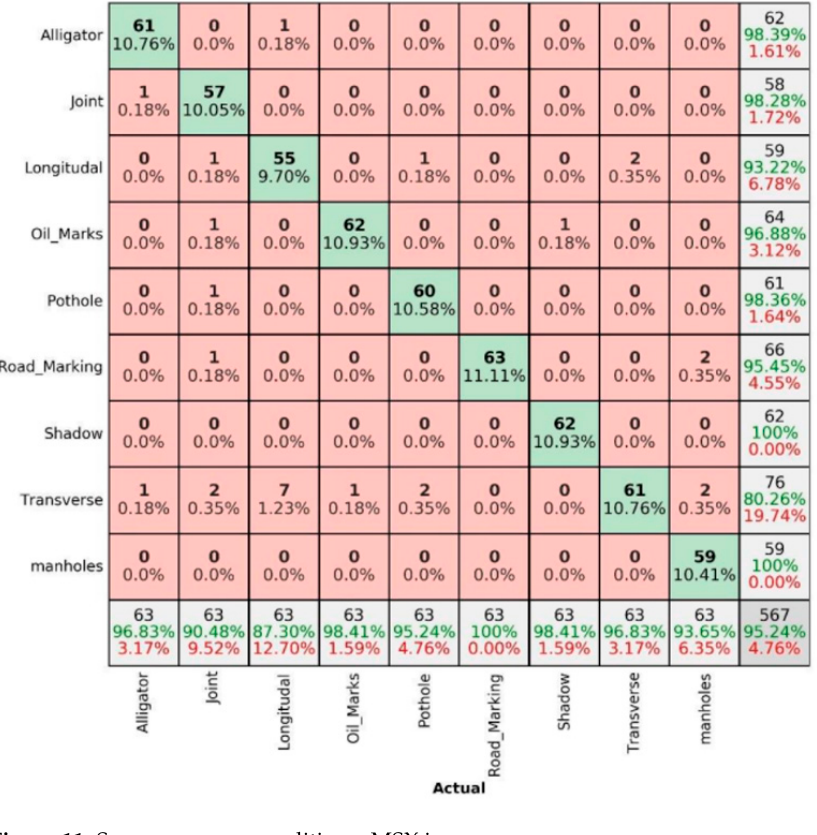
Figure 11. Summer sunny condition—MSX images.